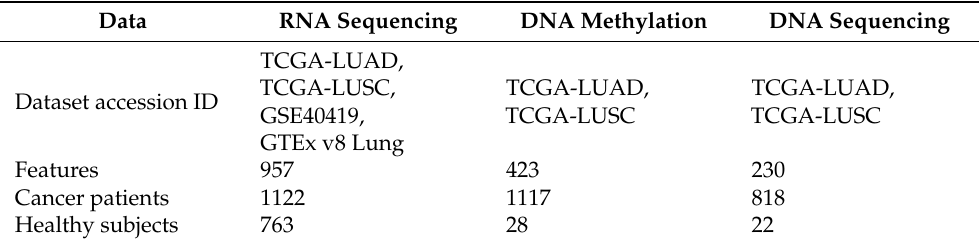
Table 1. Dataset